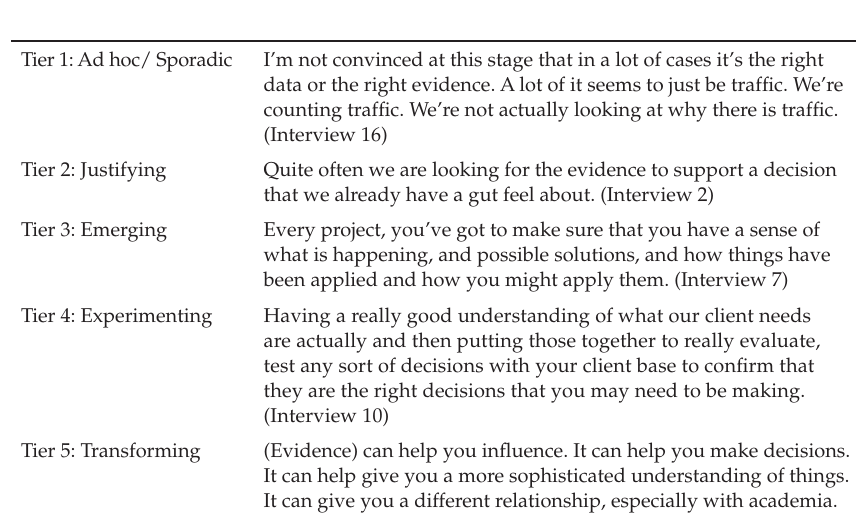
Table 1: Interviewees’ experience of the Process dimension, Evidence Based Library and Information Practice Capability Maturity